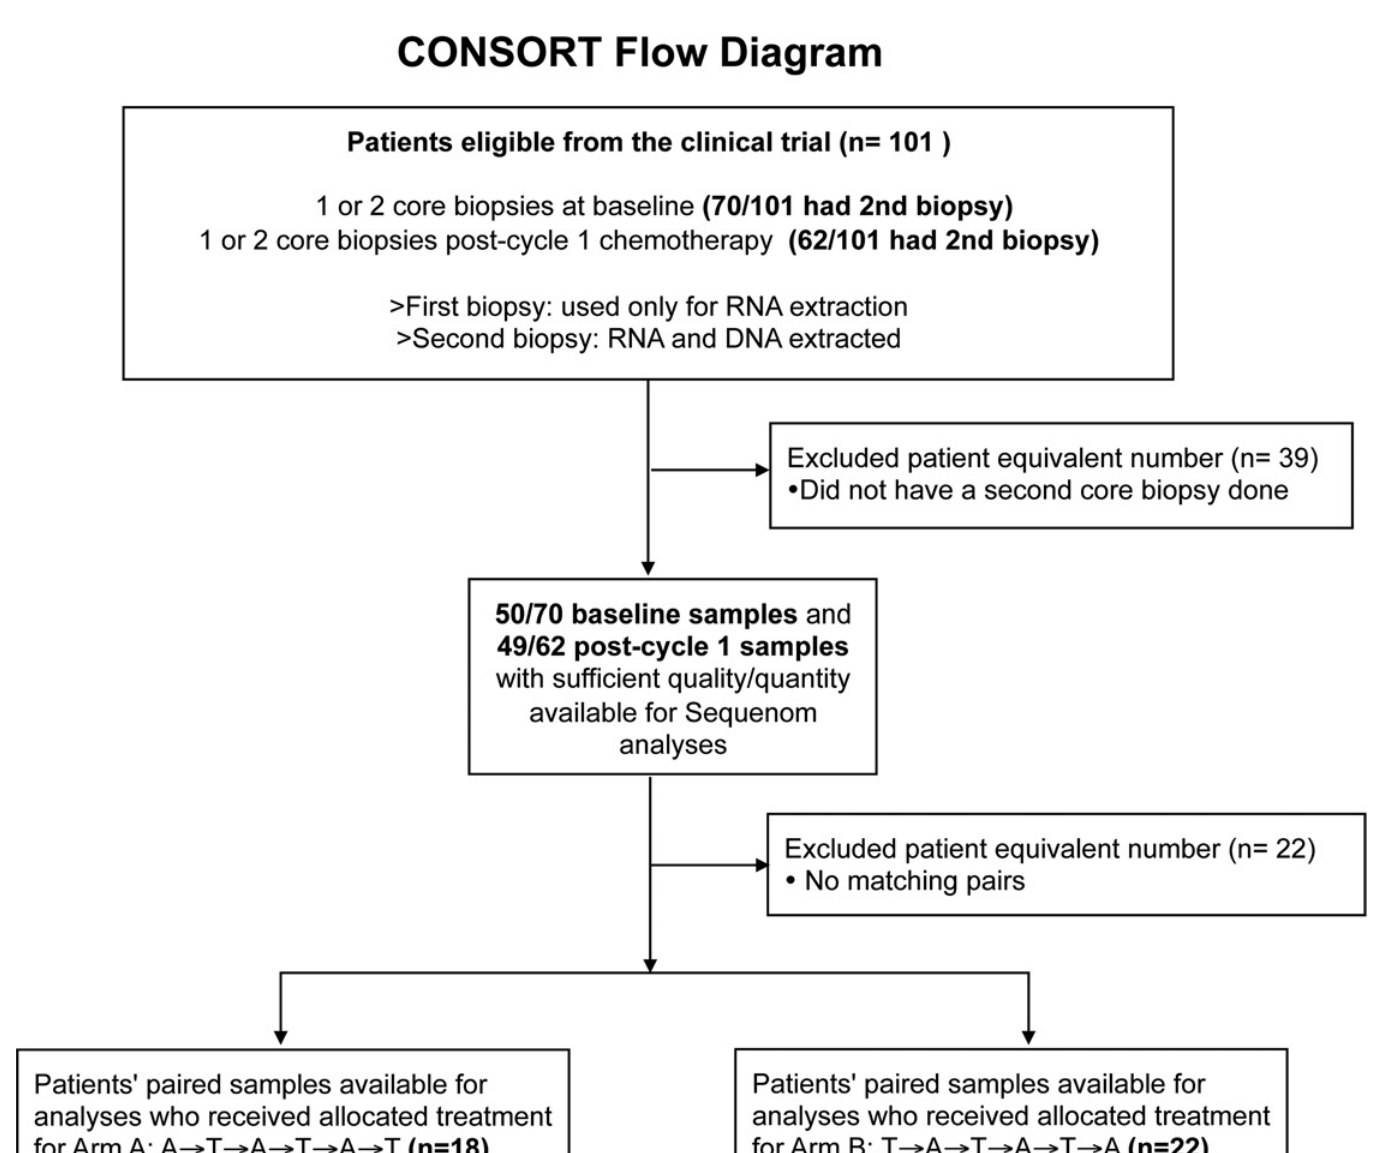
Fig 1. CONSORT flow chart in which the number of paired samples with data available for Sequenom analysis are shown.